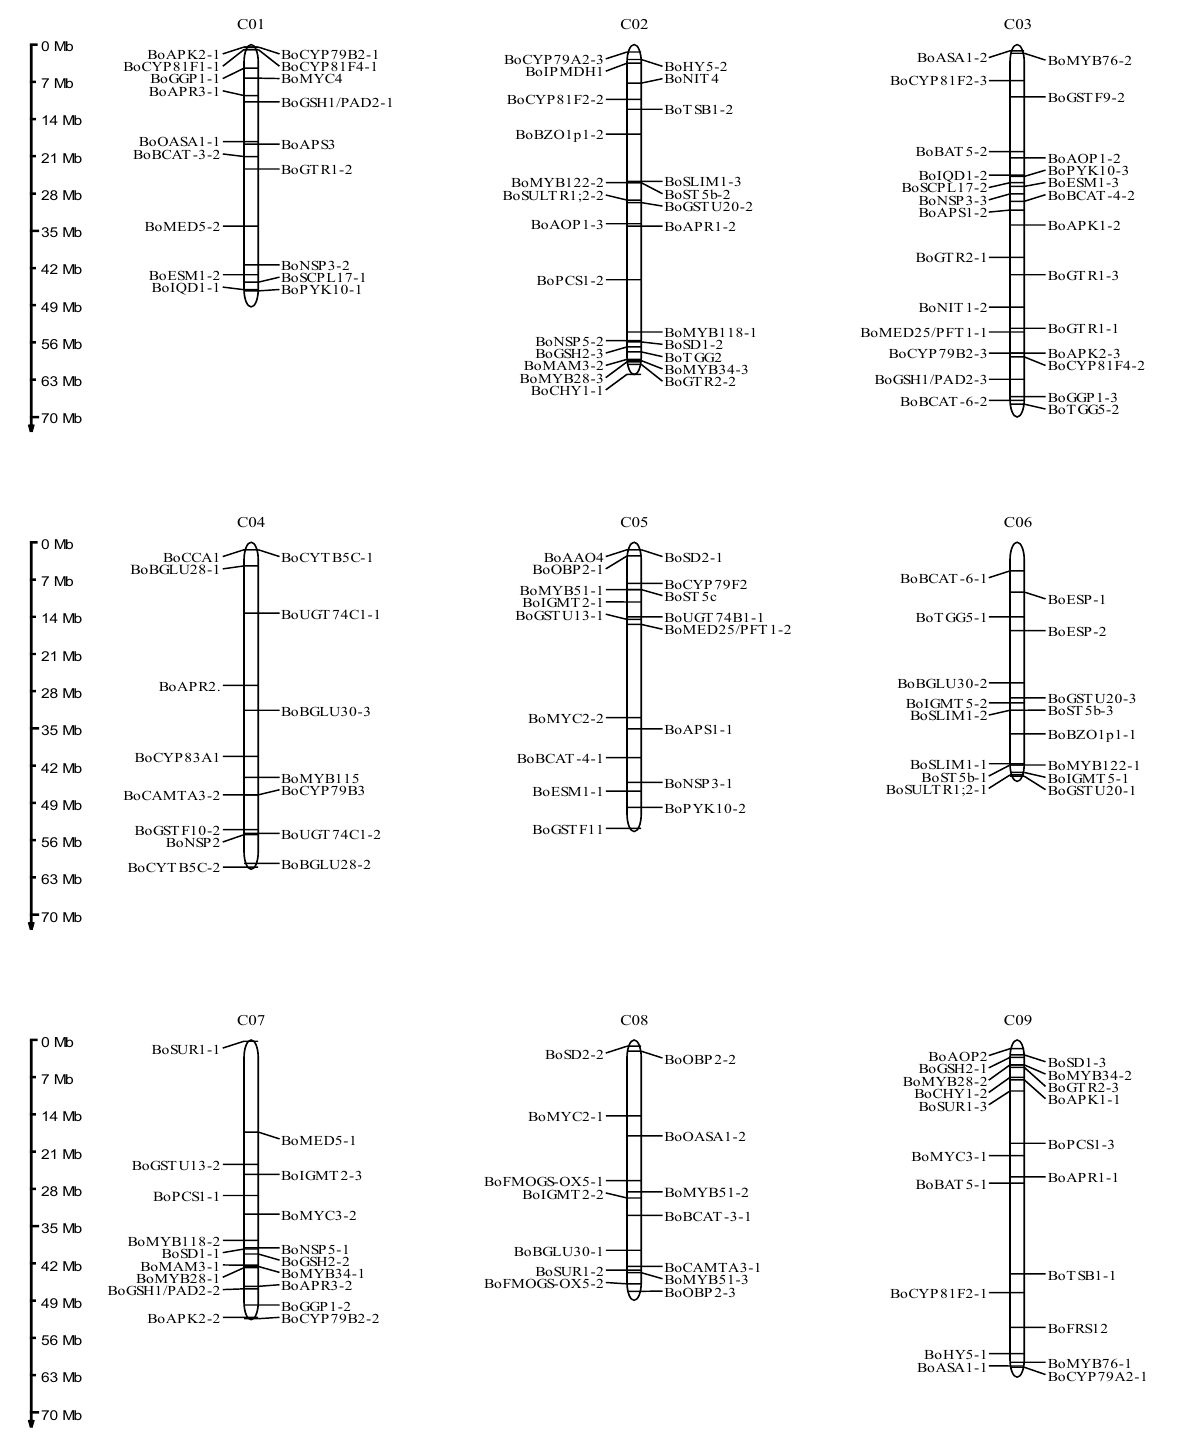
Figure 3. Genomic localization diagrams of the BoGBGs on nine chromosomes of Brassica oleracea. C01-C09 denote Brassica oleracea chromosomes.